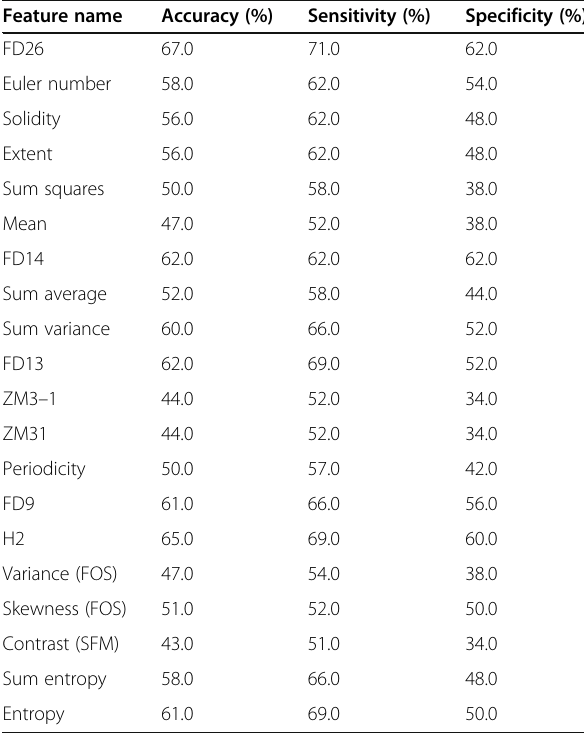
Table 12 Classification performances of the top 20 features selected by Relief-F when employed individually